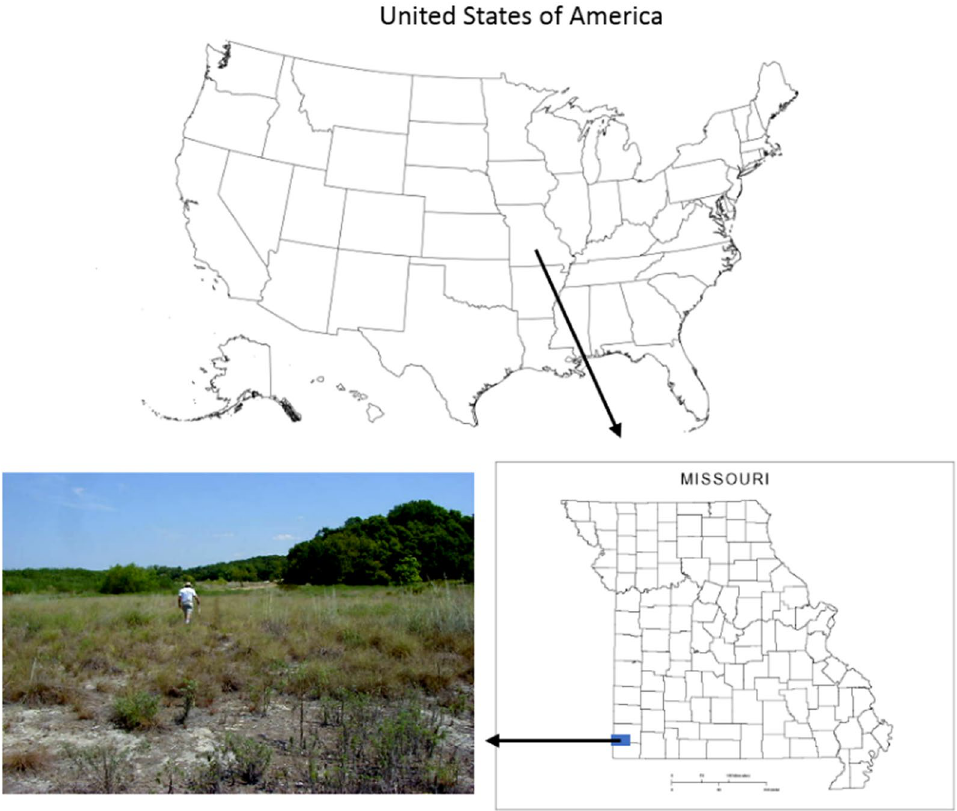
Figure1. Location and photo of the study site (USA map https:// www. pinte rest. com/ pin/ 30533 00497 40108 110/ ; MO map source: http:// www. yello wmaps. com/ map/ misso uri- blank- map- 115.